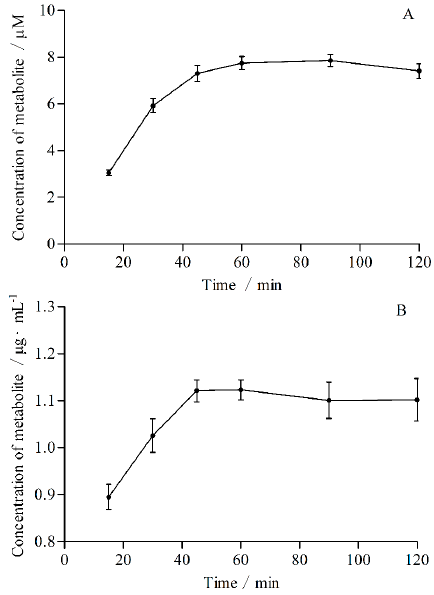
Figure 1. Influences of incubation times on the production rates of 4-nitrocatechol ( A ) and 6 β -hydroxytestosterone ( B